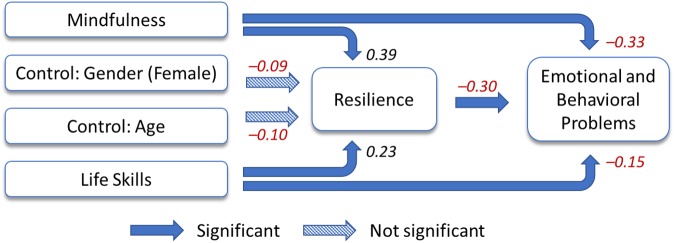
Estimated standardized coefficients of the path model.